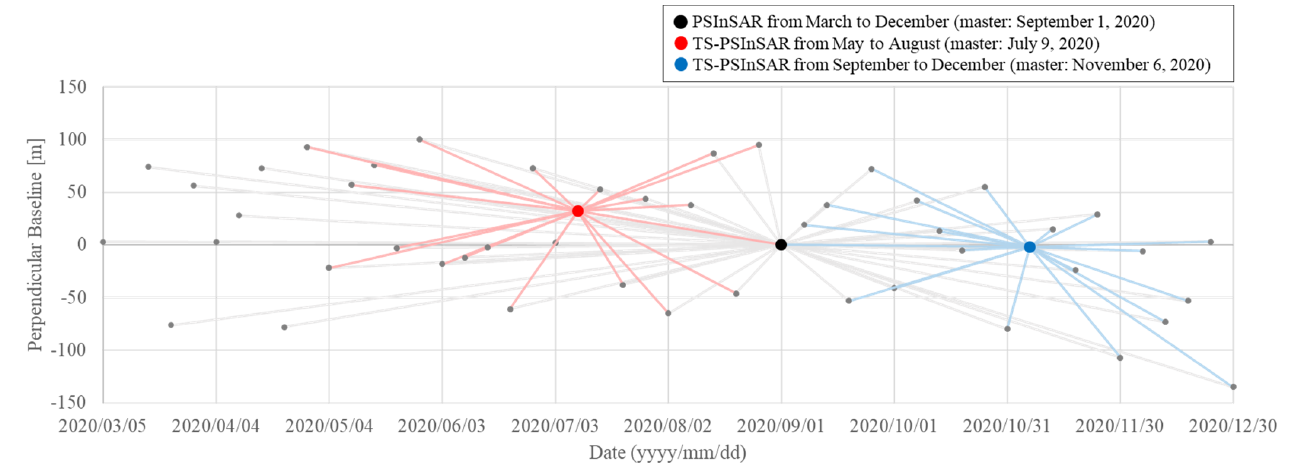
Figure 7. Baseline plots of Sentinel-1 interferograms performed as a test. The red, blue, and grey lines are the baselines between the master image and the slave images.